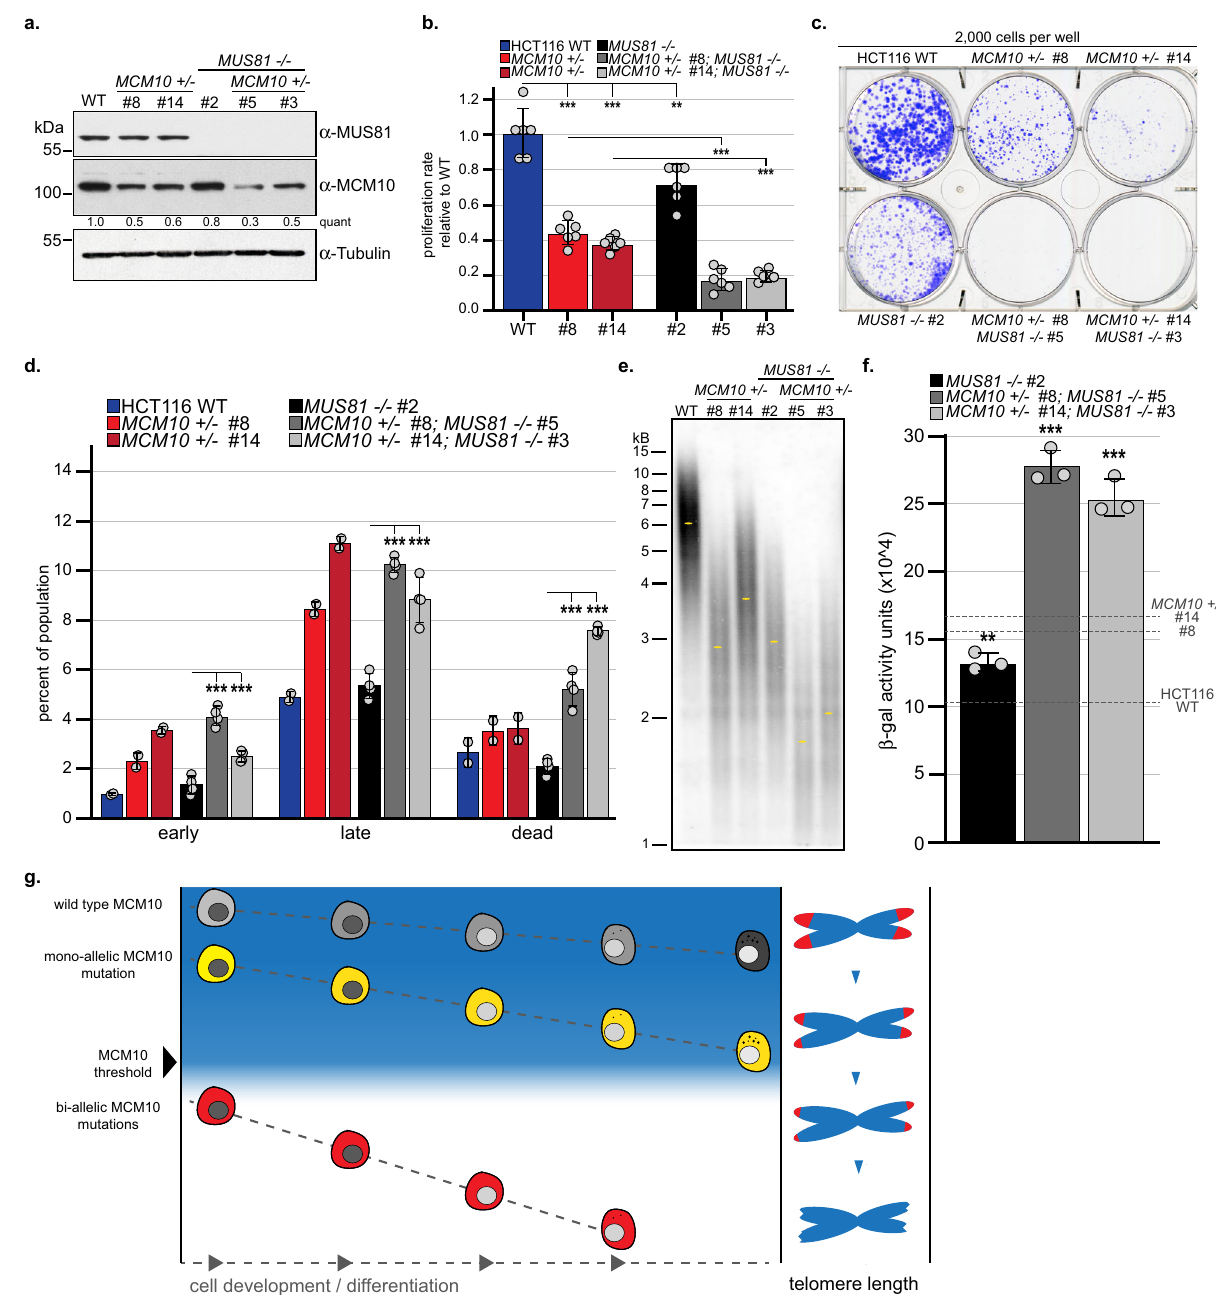
Fig. 8 Loss of MUS81 increases the severity of proliferation, viability, and telomere length defects in MCM10 + /- cell lines. a Western blots for MUS81 and MCM10. Quanti fi cation normalized to tubulin relative to the wild type sample is indicated. b Average proliferation rate in HCT116 wild type, MUS81 -/- , MCM10 + /- and double mutant cell lines normalized to HCT116 wild type, n = 6. Individual data points are indicated (gray circles). c Comparison of clonogenic survival of HCT116 wild type, MUS81 -/- , MCM10 + /- and double mutant cell lines. d Average percentage of each population represented by early apoptotic, late apoptotic or dead cells in HCT116 wild-type, MUS81 -/- , MCM10 + /- and double mutant cell lines, n = 2 replicates for HCT116 wild type and MCM10 + /- single mutants; n = 4 for all MUS81 -/- cell lines. Individual data points are indicated (gray circles). e TRF analysis of early passage HCT116 wild type, MUS81 -/- , MCM10 + /- and double mutant cell lines. Location of peak intensity (yellow dots) is indicated. f β -gal activity expressed as arbitrary fl uorescence units normalized to total protein for MUS81 -/- (black) and MUS81 -/- , MCM10 + /- mutant cell lines (gray). Average levels for HCT116 wild type and MCM10 + /- cell lines from Supplementary Fig. 3d are indicated with dashed lines, n = 3. Individual data points are indicated (gray circles). Error bars in b , d , and f indicate SD and signi fi cance was calculated using an unpaired, two-tailed students t-test with *<0.05; **<0.01, ***<0.001. Source data for panels a , b , d , e , and f , including relevant exact p-values, are provided in the Source Data fi le. g Model of MCM10 -associated telomeropathies. Different cell lineages have an inherent developmental threshold for MCM10 expression to achieve complete development and differentiation. As mono- or bi-allelic variants decrease the amount of functional MCM10, telomere erosion is accelerated. When MCM10 function is reduced below the required threshold, eroded telomeres cause replicative senescence and prevent complete